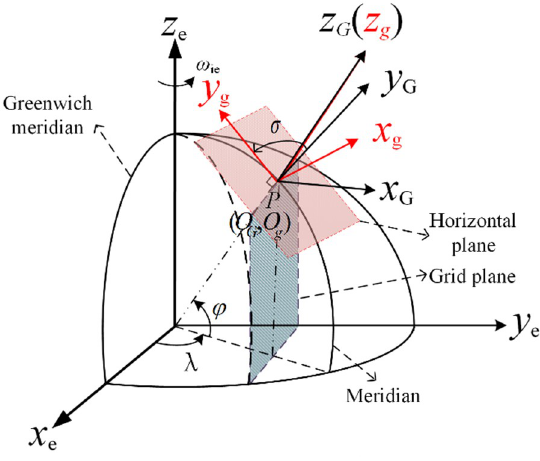
Figure 1. Description of the grid frame.